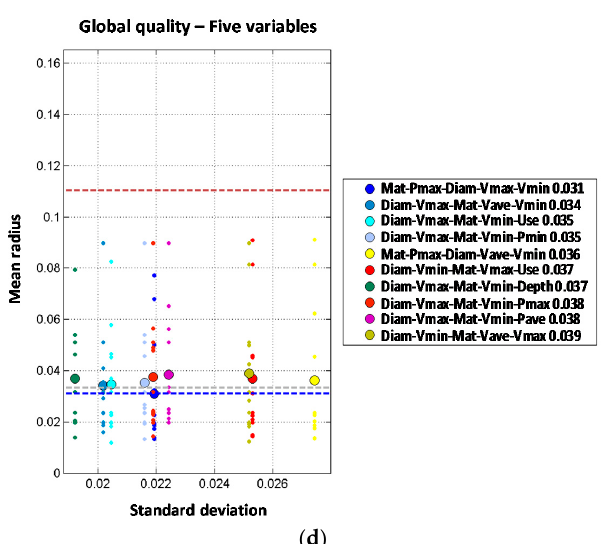
Figure 7. Trunk mains. Mean radius and standard deviation for models with two joint variables plus independent variables. Order zero mean radius is represented with brown dotted line; and best predictive model with blue line for: ( a ) order two; ( b ) order three; ( c ) order four and ( d ) order five models.